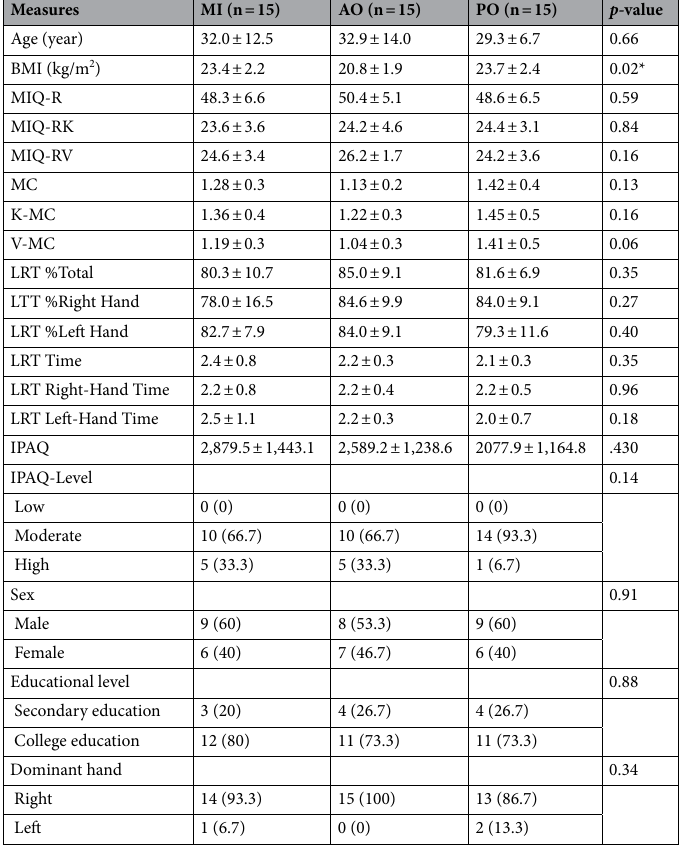
Table 1. Descriptive statistics for the sociodemographic and self-reported data. Values are presented as mean ± standard deviation or number (%). AO action observation, BMI body mass index, IPAQ International Physical Activity Questionnaires, K kinesthetic subscale, LRT laterality recognition task, MI motor imagery, MIQ-R movement imagery questionnaire-revised, MC mental chronometry, PO placebo observation group, V visual subscale, %,